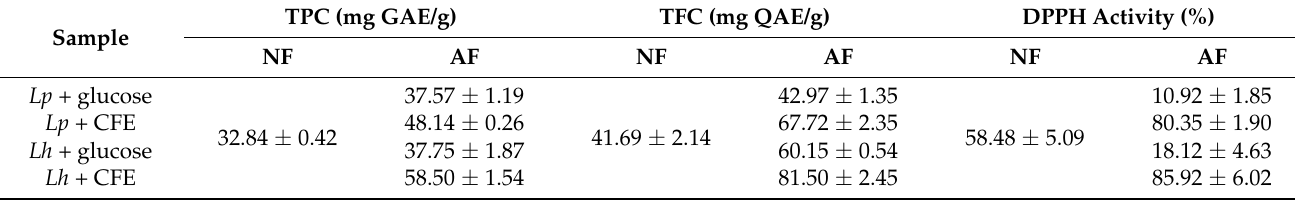
Table 4. TPC, TFC, and DPPH activity of glucose and CFE during